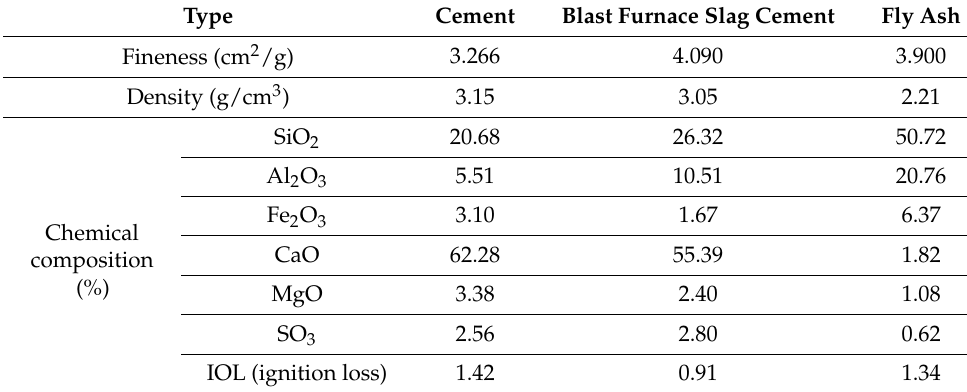
Table 2. Chemical and physical composition of binders.